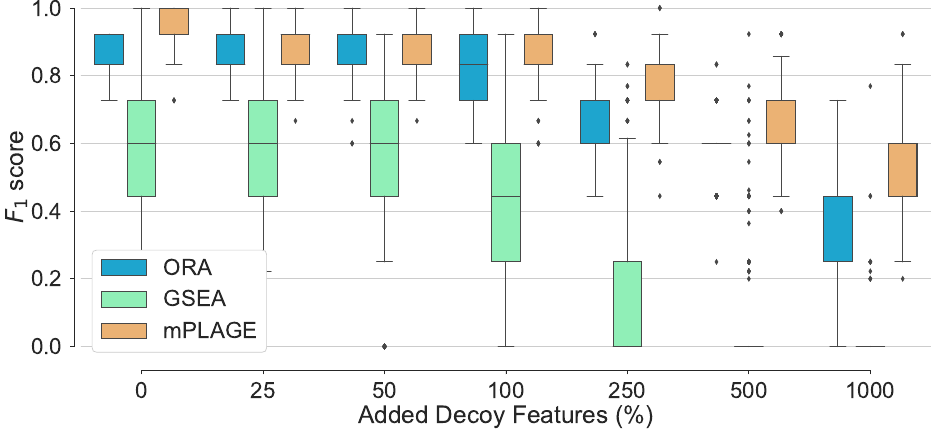
Figure 3. Overall performance of the different pathway ranking methods. Distribution of the F 1 for each method under increasing levels of decoy features is shown with outliers displayed as small diamonds. The performance of mPLAGE and ORA are roughly similar using 0–100% decoy levels, but mPLAGE performs better returning greater F 1 -scores at higher decoy